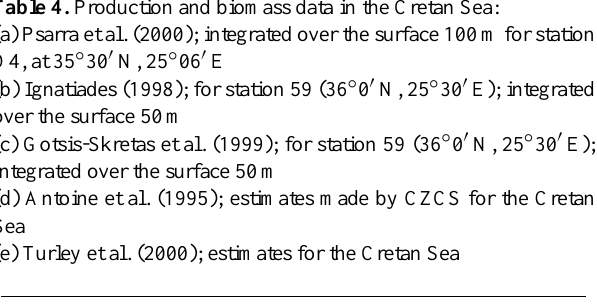
Table 4. Production and biomass data in the Cretan Sea: (a) Psarra et al. (2000); integrated over the surface 100m for station D4, at 35 ◦ 30 0 N, 25 ◦ 06 0 E